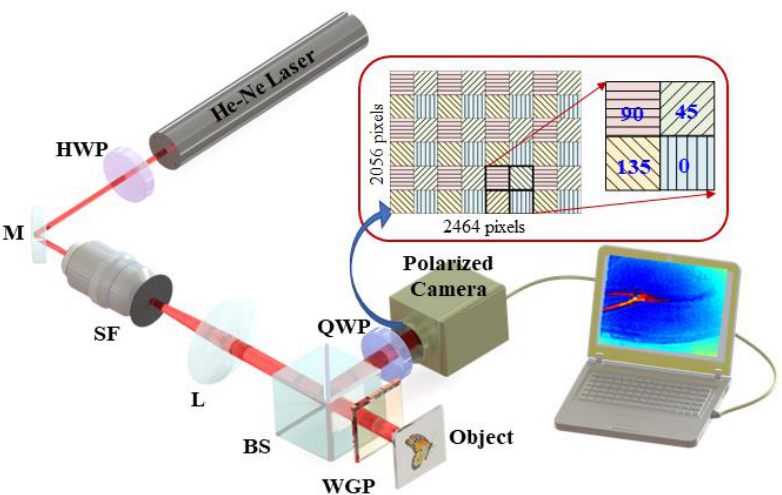
Figure 2. Experimental geometry of FP-PSDH: He-Ne laser: Helium-Neon laser source; HWP: Half Wave Plate; M: Mirror; SF: Spatial Filter assembly; L: Lens; BS: Nonpolarizing Beam Splitter; WGP: Wire Grid Polarizer; QWP: Quarter Wave Plate. In inset, the polarization filter arrangements in the polarized camera and respective orientation angles are represented.